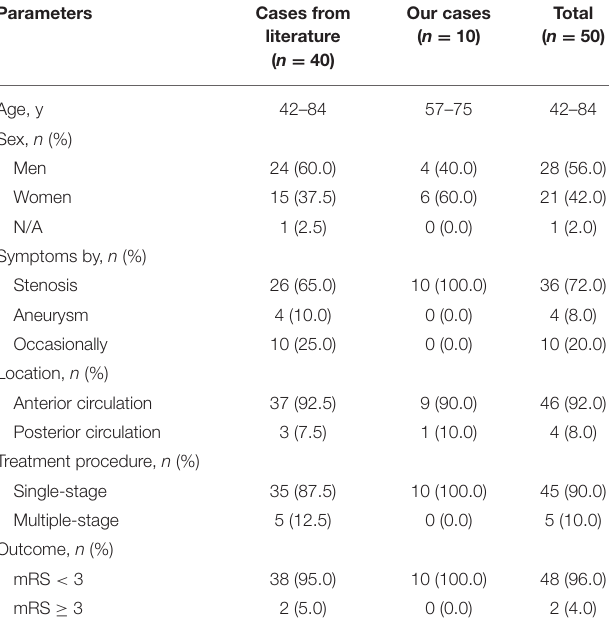
TABLE 2 | Patients’ characteristics and